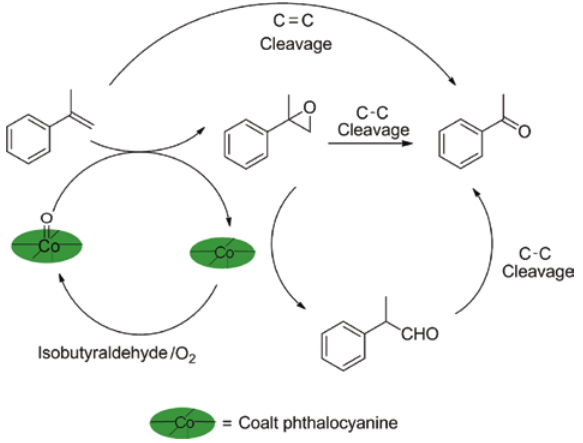
Scheme 5: The possible mechanism of the